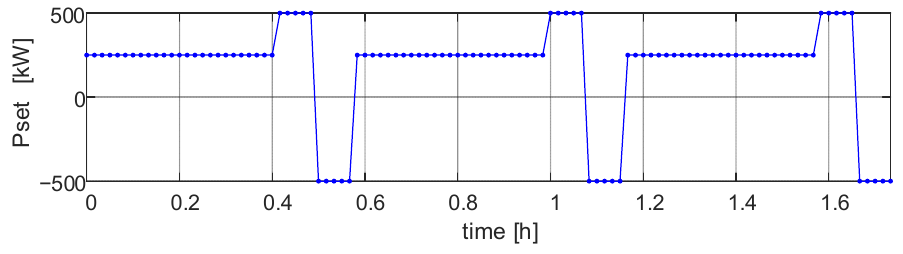
Figure 9. Set operation plan of the BESS.